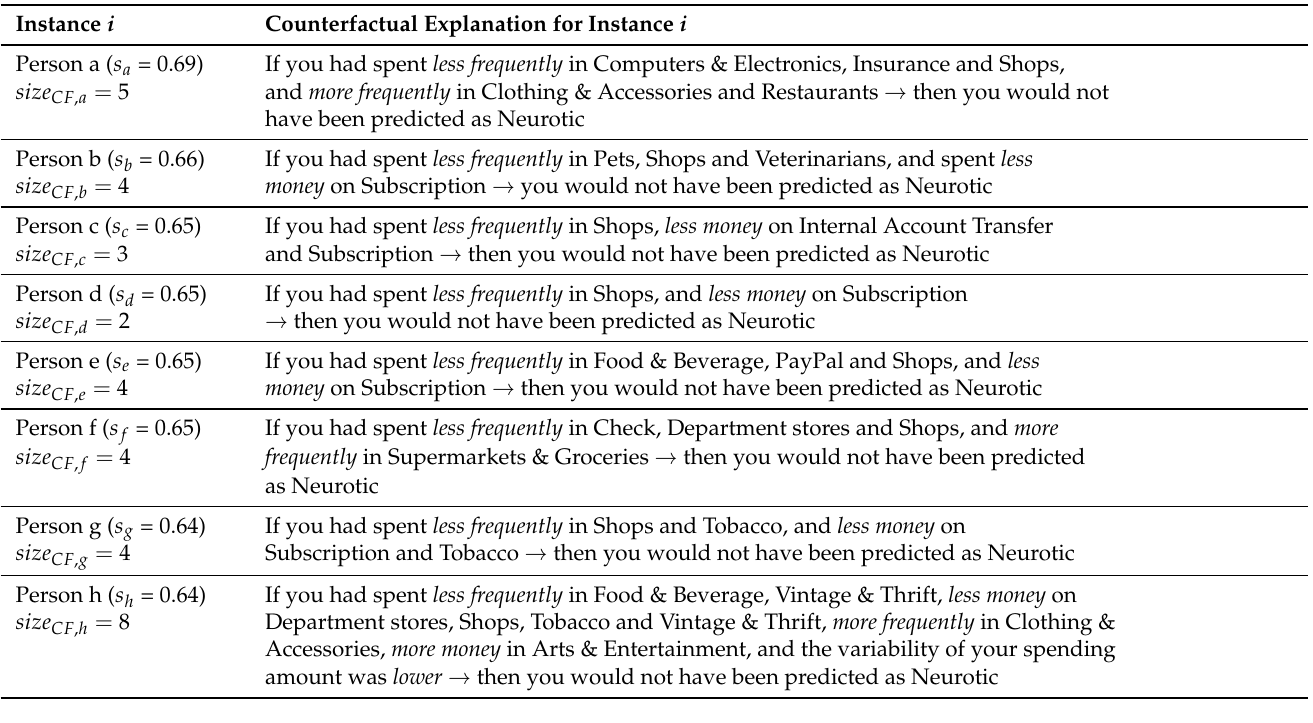
Table 4. Local explanations that show the features that (counterfactually) explain the predicted class High Neuroticism. A selection of explanations is shown for instances i with highest predicted scores s i